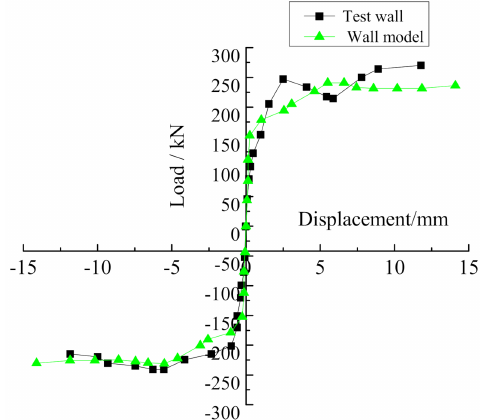
Figure 14. Load-displacement skeleton curves.